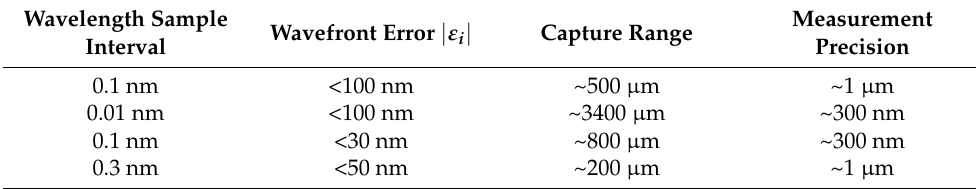
Table 1. Measurement range and precision in deference